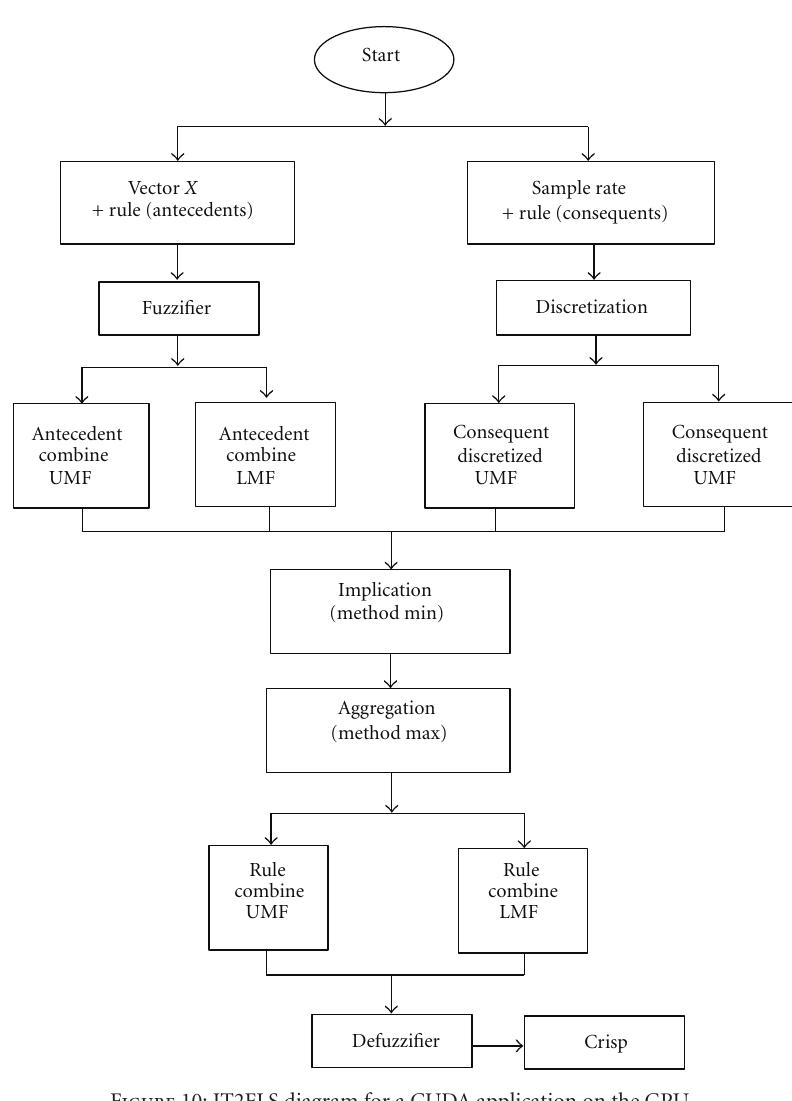
Figure 10: IT2FLS diagram for a CUDA application on the GPU.